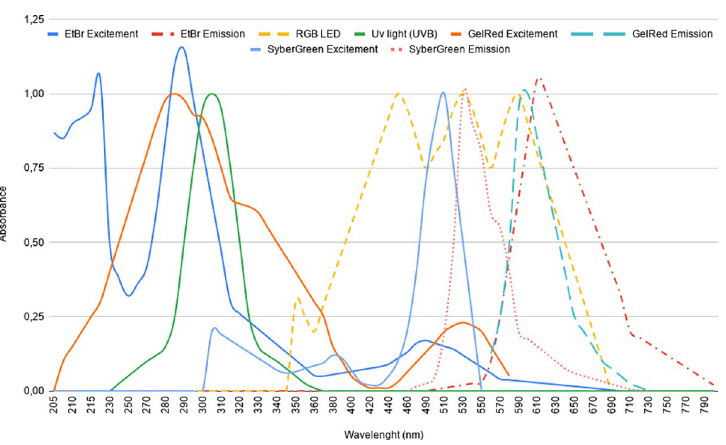
Fig 4. Plot representing the emission and excitation of the used dyes. Wavelengths are in the range of 205–790 nm (UV until visible). Full and dashed lines represent the emission and excitement wavelengths, respectively.